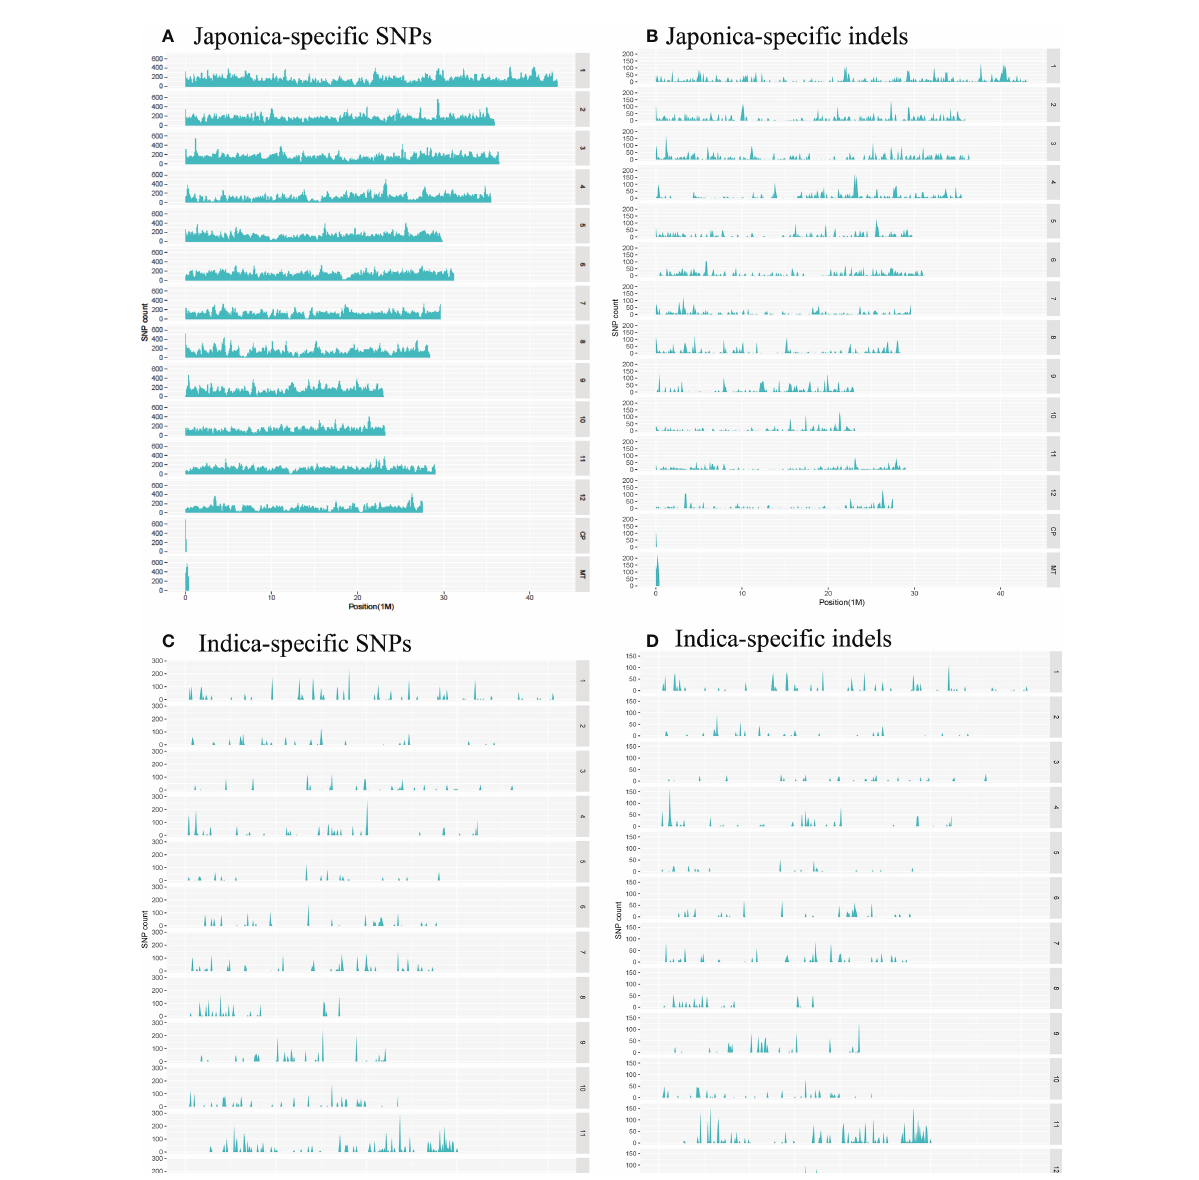
FIGURE 4 Distribution of the converted SNPs on the array in 100 Kb windows along the rice chromosomes. (A) Density of japonica-speci fi c SNPs across chromosomes. (B) Density of japonica-speci fi c indels across chromosomes (C) Density of indica-speci fi c SNPs across chromosomes (D) Density of indica-speci fi c indels across